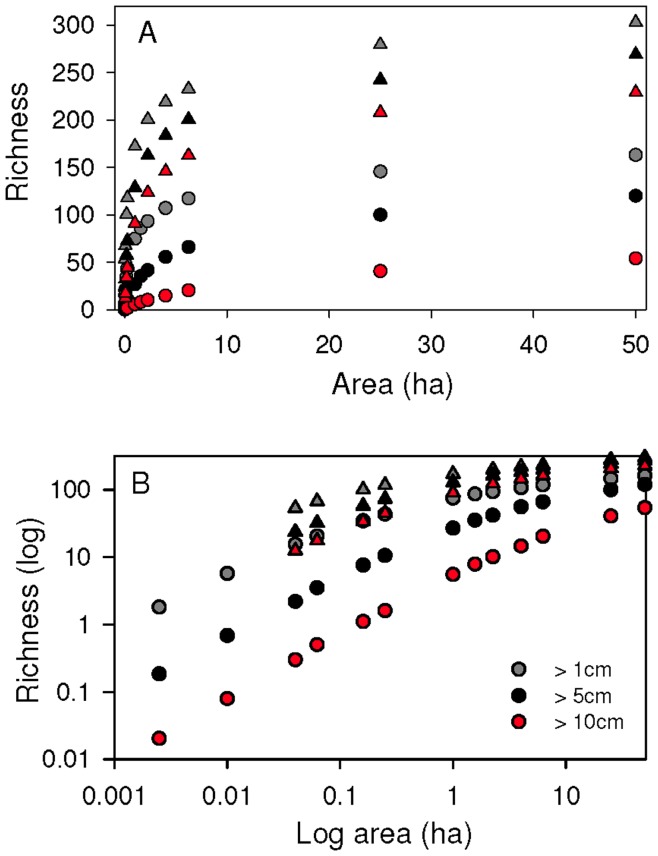
Liana and tree species-area curves for three size classes over 50 ha on Barro Colorado Island, Panama.Triangles represent trees and circles represent lianas. Panel A is based on untransformed data and panel B is based on transformed data.